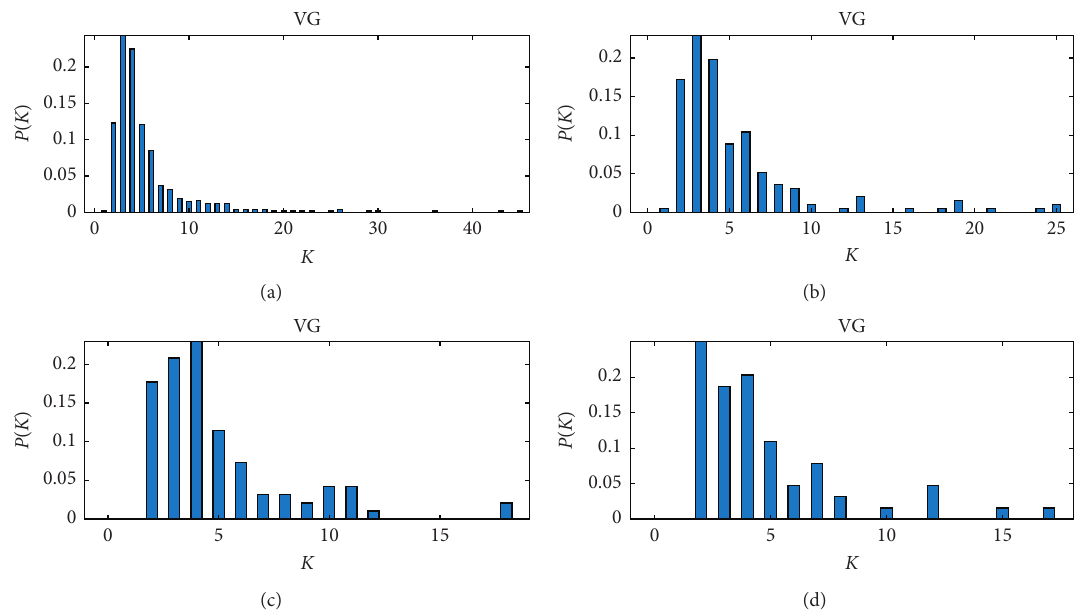
Figure 10: Degree distribution of visual graph. (a) Δ t � 2min. (b) Δ t � 5min. (c) Δ t � 10min. (d) Δ t � 15min.